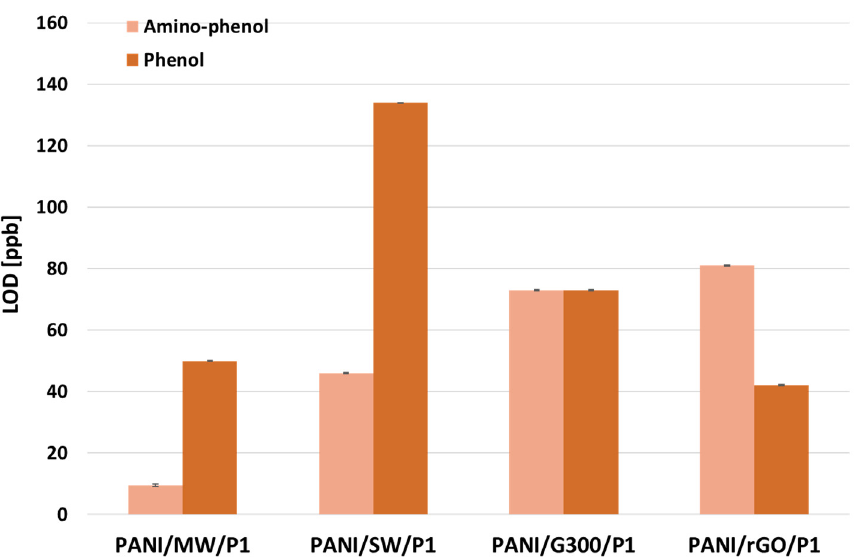
Figure 9. Histograms showing the LOD of the PANI sensor as a function of carbon type of aminophenol and phenol.